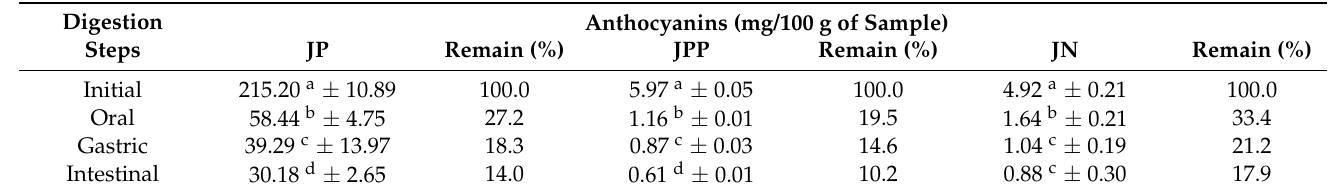
Table 1. Determination of anthocyanins during the simulated digestion process (in vitro) of jussara